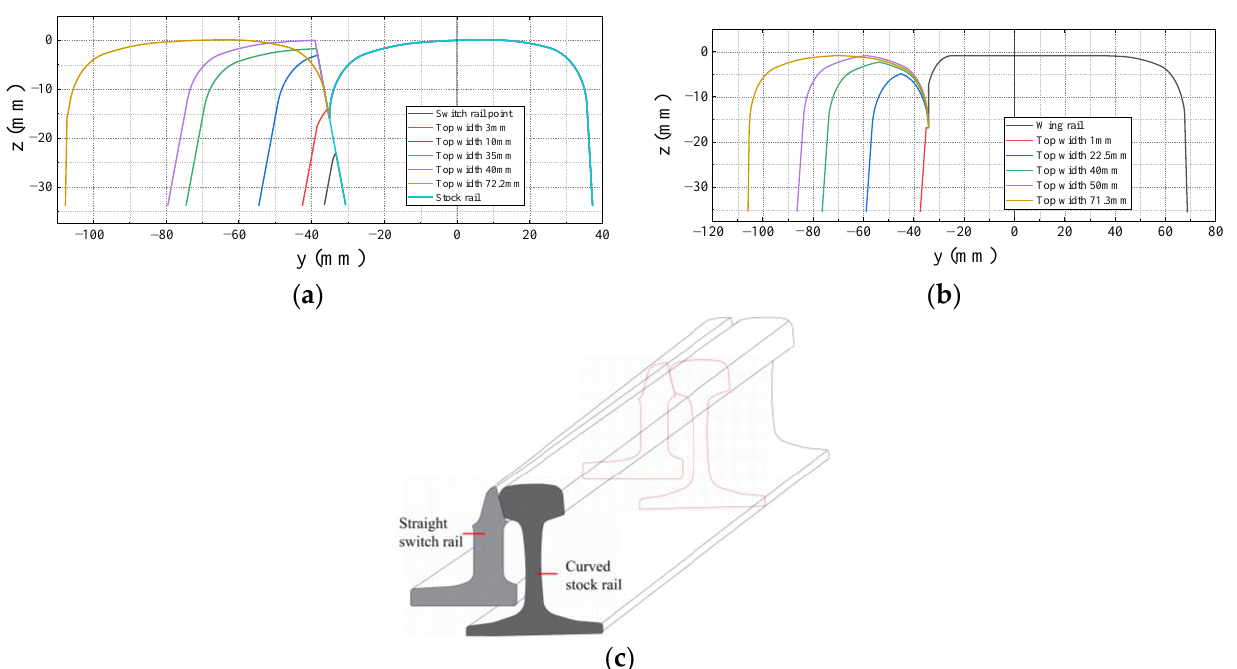
[30]. This ensures a smooth transition from one rail profile to the next profile.